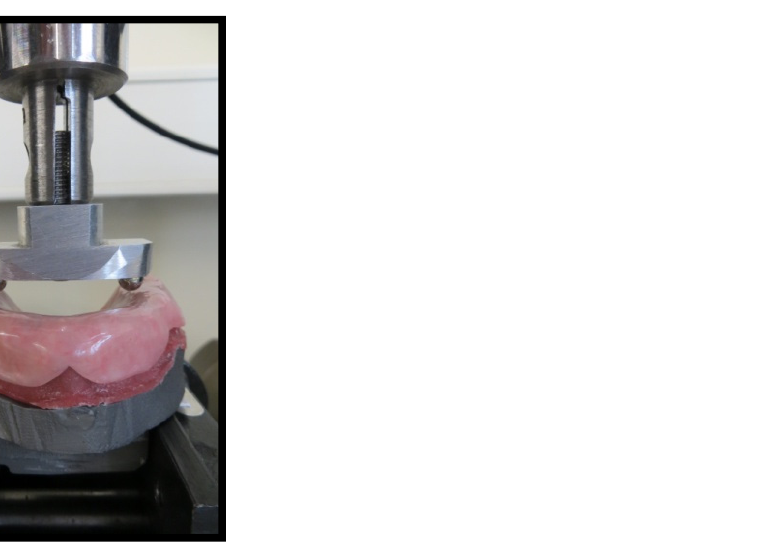
Table 3. Average maximum masticatory strength of each type of material for low- and high-alveolar-ridge groups.